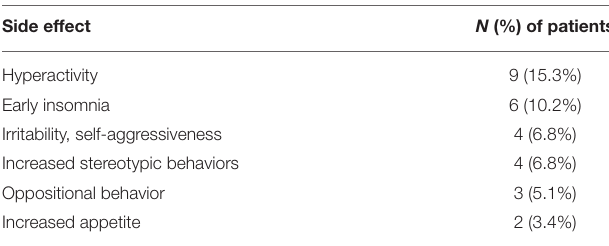
TABLE 4 | Side effects recorded during metabolic support